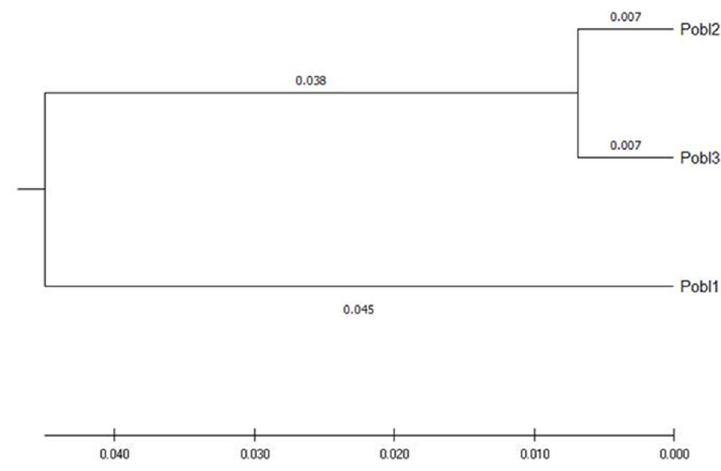
7 of 12 Table 6. FST pairwise comparison of populations using paired t ‐ tests. Significance matrix FST ( p =